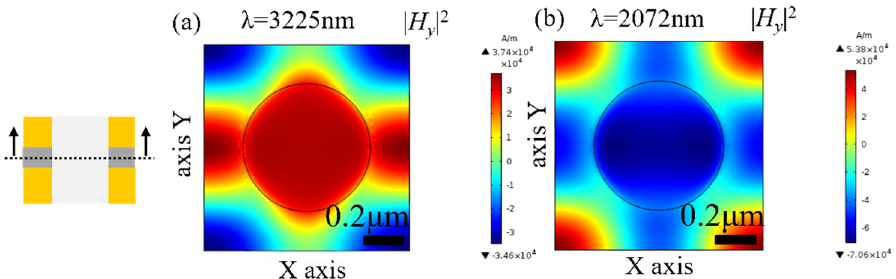
Figure 5. ( a ) The magnetic field distribution at λ = 3225 nm, ( b ) the magnetic field distribution at λ = 2072 nm in the x-y plane of the middle of MgF 2 layer ( z = 0).